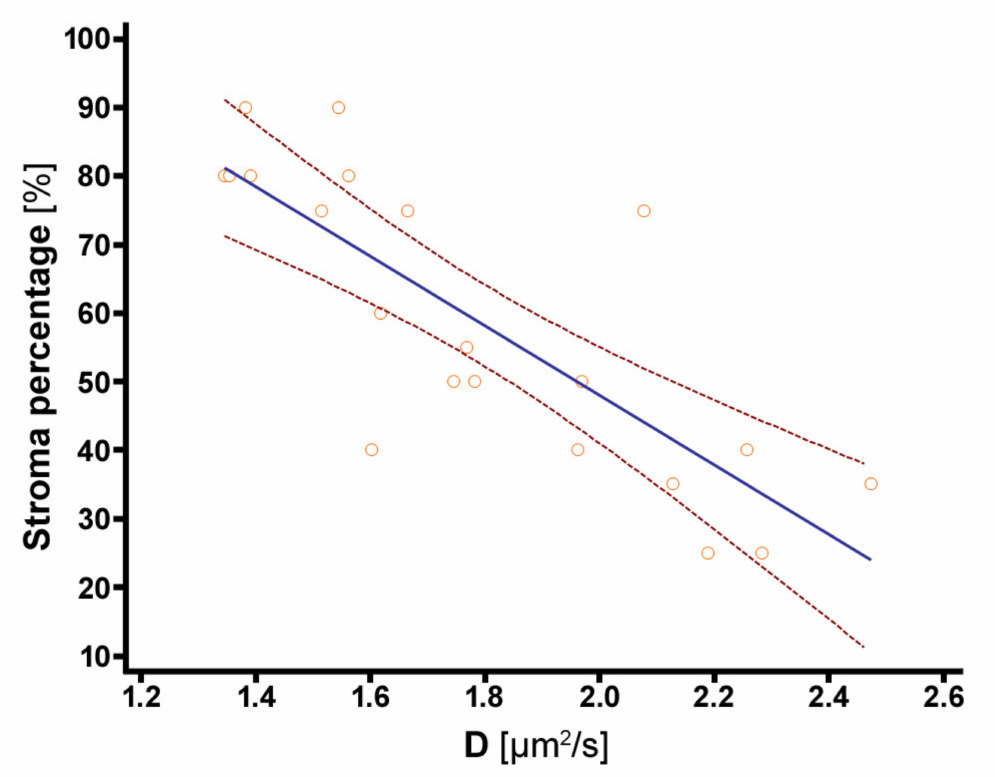
Figure 3. Dependency of stroma percentage on di ff usion coe ffi cient D from DKI. Linear regression (cid:20) (cid:21) (cid:20) µ (cid:21) m 2 ∗ D % s + 149.522 [ % ] . Goodness of fit: R 2 = 0.6498. model: Stroma percentage [ % ] = − 50.799 µ m 2 s The curves next to the regression line represent the 95% confidence interval. There was a significant strong negative rank correlation between D tumor and stroma percentage (r s = − 0.852, p < 0.001). ROC curves of D tumor , K tumor , and ADC tumor for predicting high stroma percentage > 50% are plotted in Figure 4. The AUC values of D tumor , K tumor , and ADC tumor were 0.918 (95% CI: 0.714 to 0.992, p < 0.001), 0.582 (95% CI: 0.350 to 0.790, p = 0.550) and 0.645 (95% CI: 0.410 to 0.839, p =